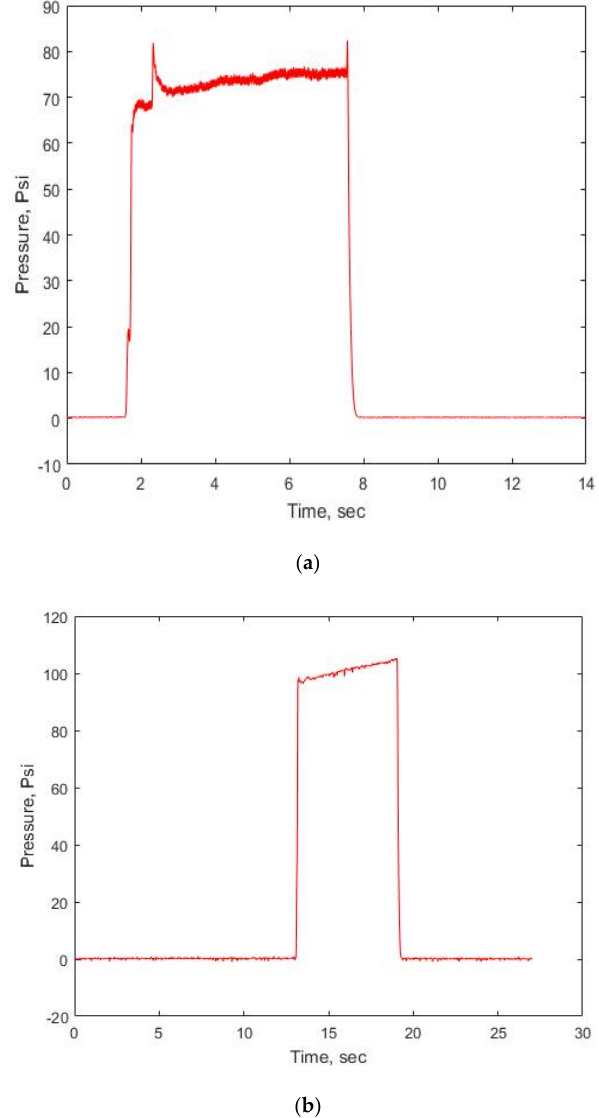
Figure 11. Pressure-time data using ( a ) shower head injector and ( b ) multi-angle diverging injector for PVC fuel.